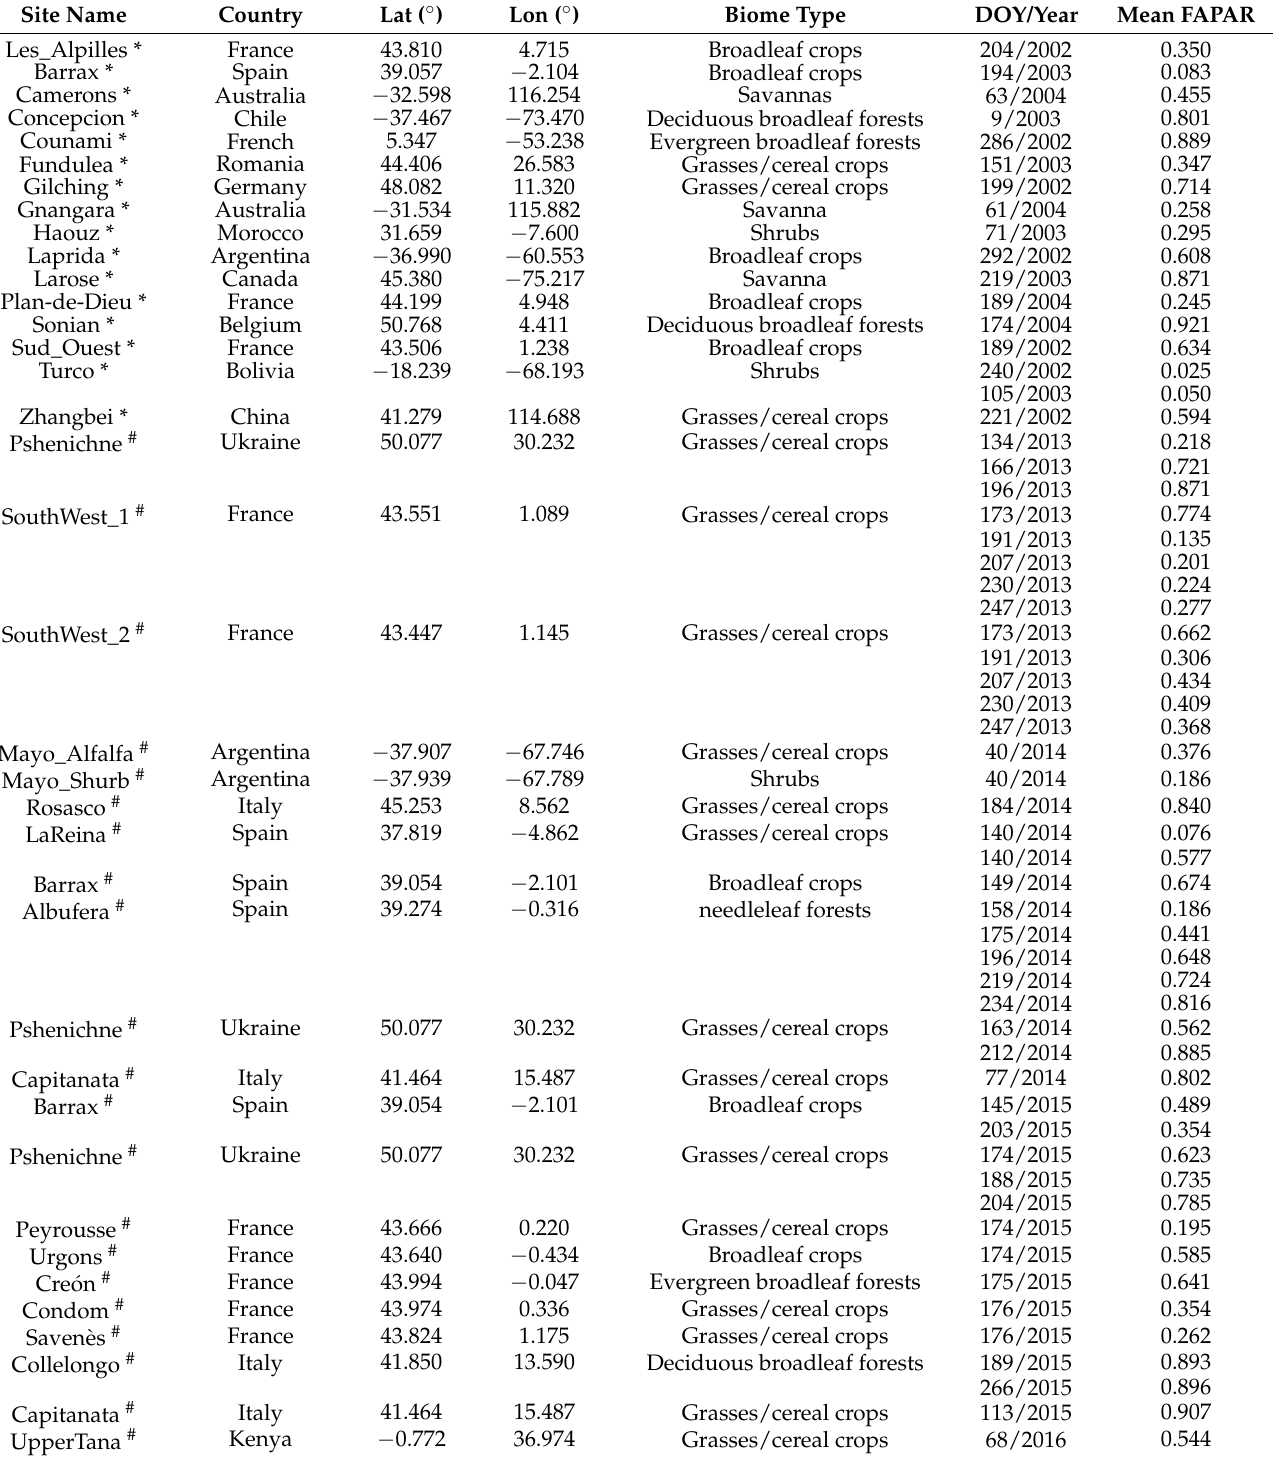
Table 1. Main characteristics of the selected sites and their mean FAPAR values of a 500 × 500 m region (DOY, day of